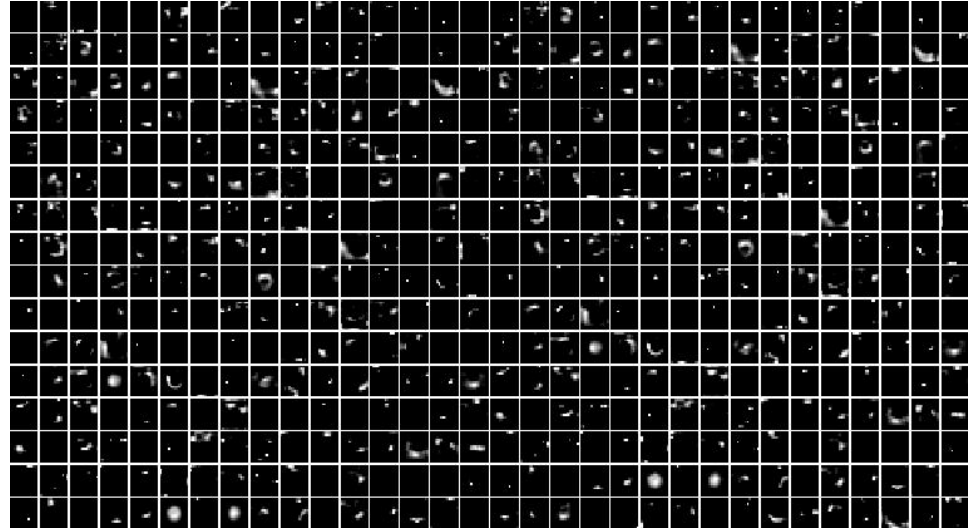
Figure 5. The first 512 channels of deep features from conv